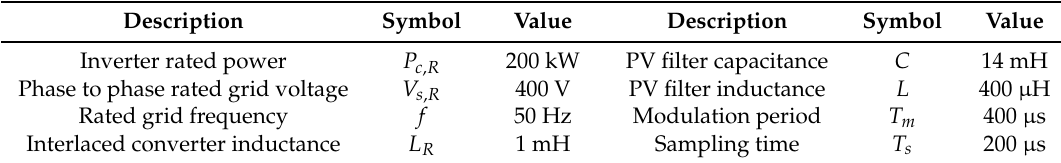
Table 2. Main parameters of the system.